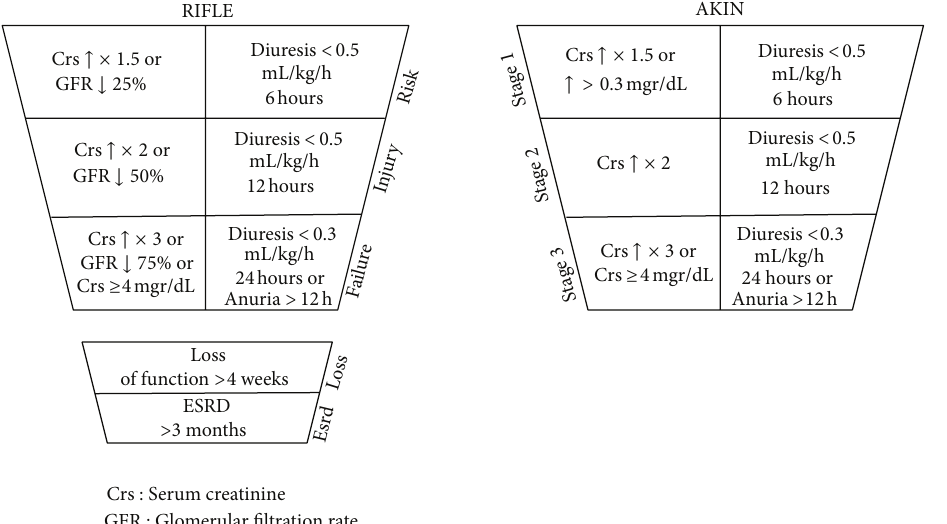
Figure 4: RIFLE and AKIN classification systems [3,